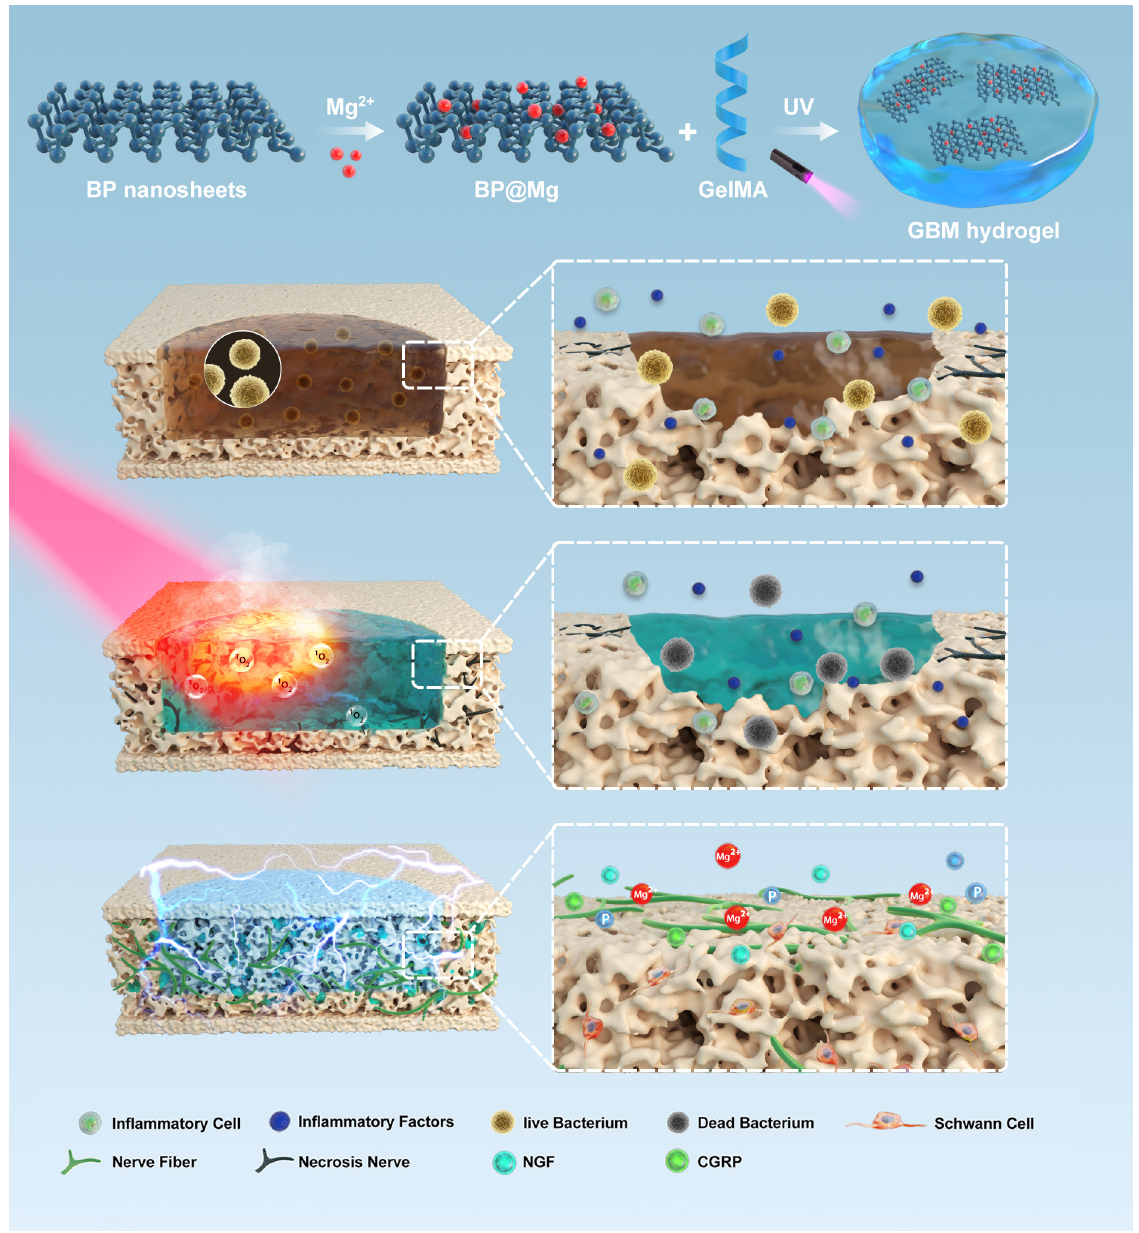
Figure 6. Schematic of GelMA-BP@Mg (GBM) hydrogel for antibacterial and innerved bone regen- eration of infected bone defects. Under NIR irradiation, GBM hydrogel displays a high antibacterial efficiency and reduces the damage to bone tissue by bacteria. Magnesium-modified black phos- phorus nanosheets promote skeletal-associated nerve fiber repair and accelerate bone regeneration. Reproduced with permission from [83], Advanced Healthcare Materials,